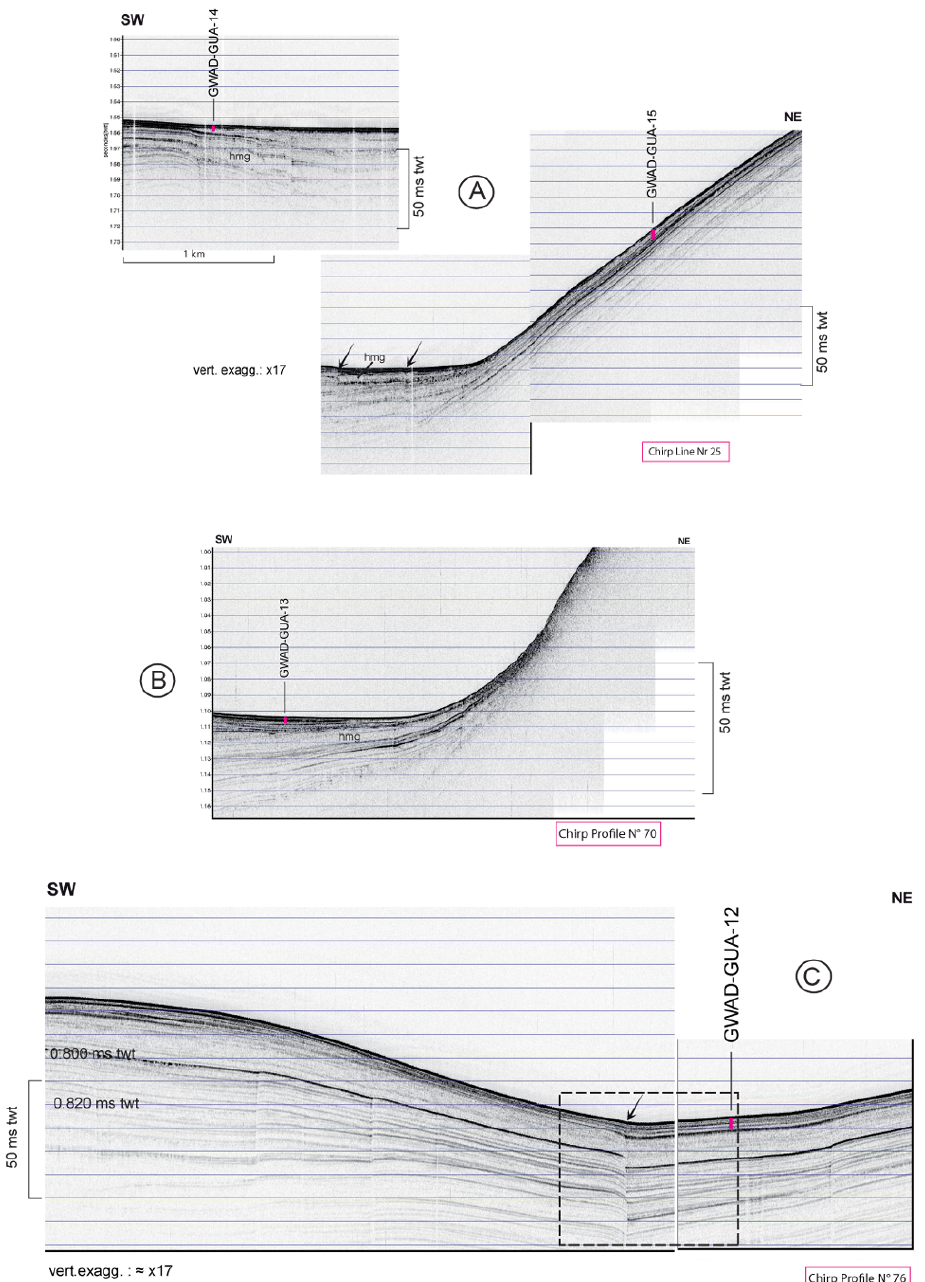
Fig. 3. Portions of VHR (chirp) seismic profiles (location on Fig. 2) and location of analyzed cores. Profiles 25 (A right) and 70 illustrate overthickening in deep troughs and associated erosion of submarine slopes and heights. Profiles 25 (A left) and 76 (black arrows) show a compensation of vertical faults offsets by specific (homogenous) deposits. (hmg: